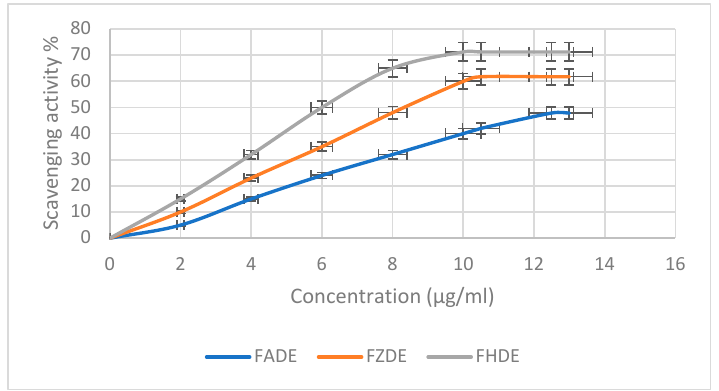
Figure 2. Antioxidant activity of FADE, FHDE, and FZDE extracts.